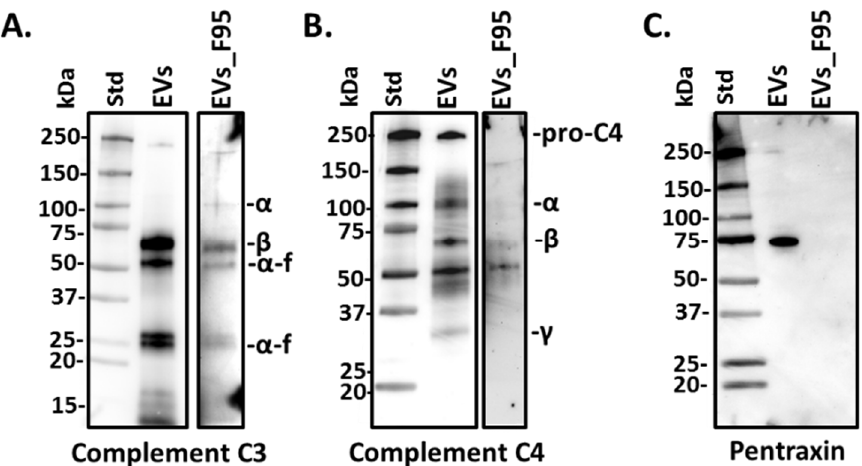
Figure 3. Complement component C3, C4 and pentraxin-like protein in halibut EVs and F95 en- riched EV fractions. Western blotting showing ( A ) complement component C3 detection in total protein cargo of halibut serum-EVs (“EVs”) and in F95-enriched protein fractions from serum-EVs (“EVs_F95”), C3 α - and β -chains, as well as α -fragment ( α -f) are indicated; ( B ) complement com- ponent C4 detection in total protein cargo of serum-EVs (“EVs”) and lower detection observed in F95-enriched EV protein fractions (“EVs_F95”), C4 α -, β - and γ -chains are indicated; ( C ) pentraxin-like protein detection in total EV protein cargo (“EVs”), which was not detected in the F95-enriched EV protein fractions (“EVs_F95”).